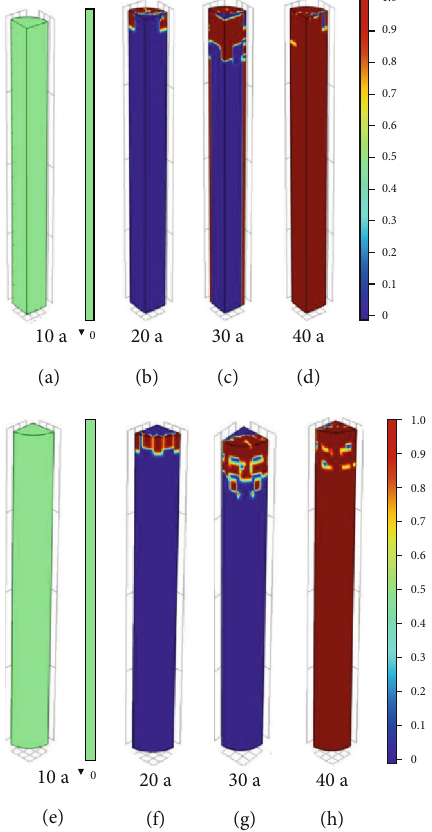
Figure 11: Failure state of concrete pile body at di ff erent times: (a) 10a, (b) 20a, (c) 30a, (d) 40a, (e) 10a, (f) 20a, (g) 30a, and (h)